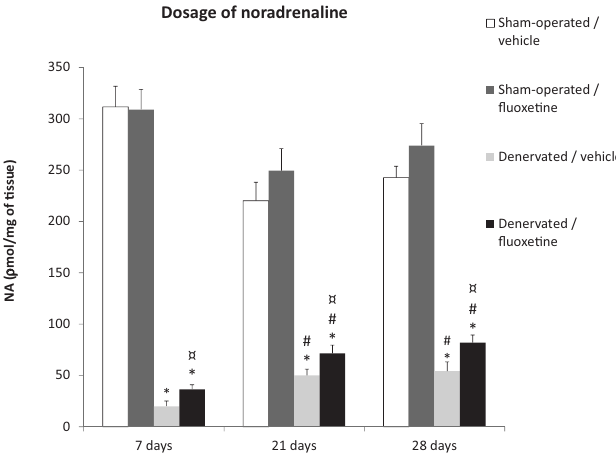
FIGURE 2 - Histogram showing the noradrenaline concentration (pmol/mg tissue) in vas deferens from sham-operated animals treated with vehicle (white), sham-operated animals treated with fluoxetine (dark gray), denervated animals treated with vehicle (light gray) or denervated animals treated with fluoxetine (black) on days 7, 21 and 28 after surgery. The bars represent the mean ± standard error of the mean of 10 experiments. ¤ indicates a significant difference in the relation to respective vehicle control group (P<0.05); * indicates a significant difference in relation to the respective sham-operated group (P<0.05); # indicates a significant difference in relation to the respective day 7 group